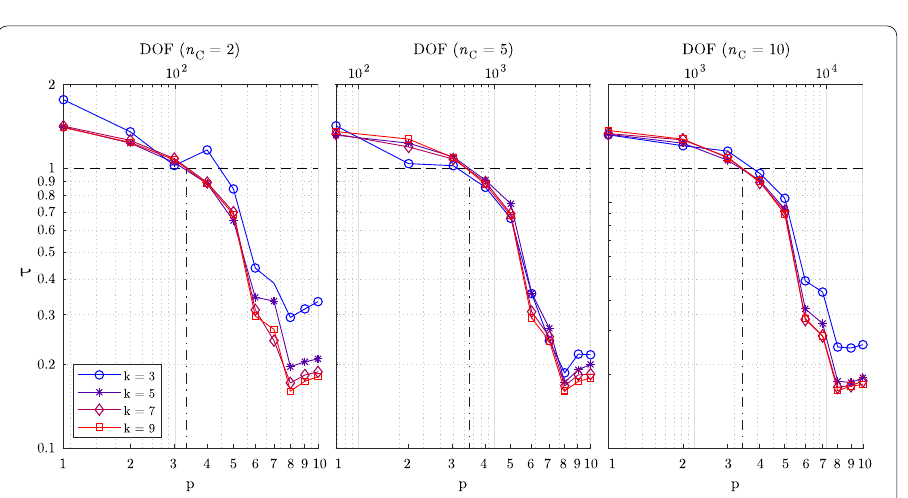
Fig. 26 Time compression ratios τ for the B-FCM + IBR method for various combinations of p , k and n C